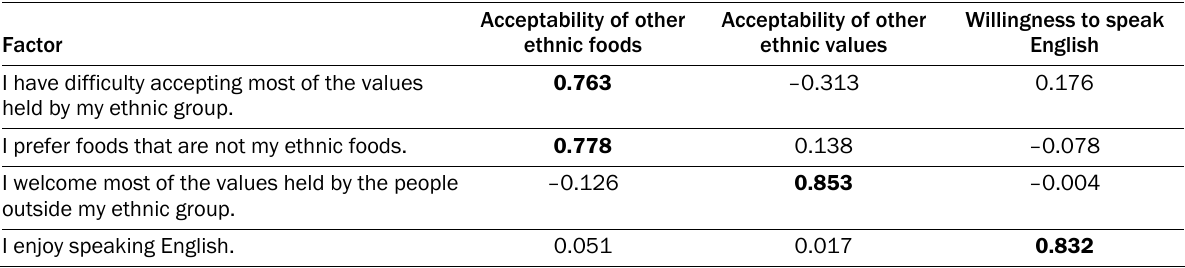
Table 9. Factors That Underlie Acculturation for Afro-Caribbean Canadians